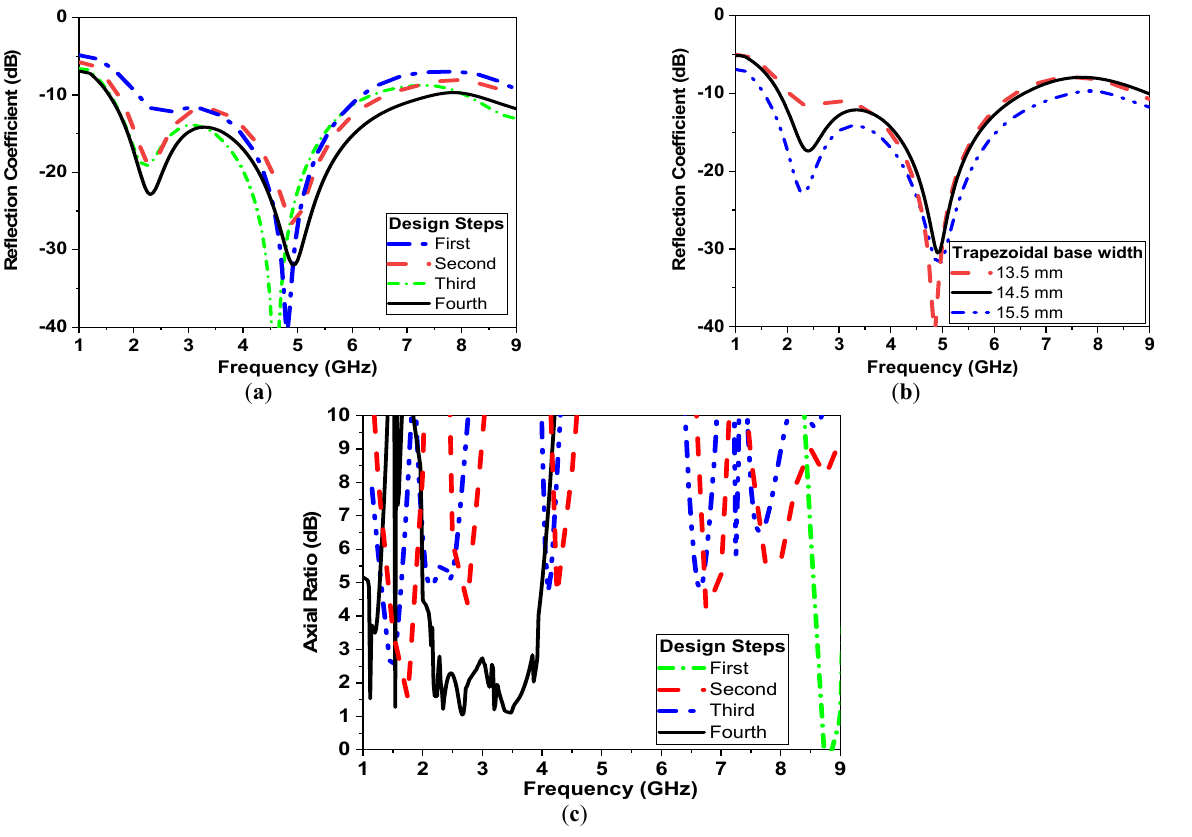
Figure 4. ( a ) |S 11 | versus frequency at different design steps, ( b ) |S 11 | versus frequency at different trapezoidal base widths, and ( c ) axial ratio (AR) in dB versus frequency at different design steps.